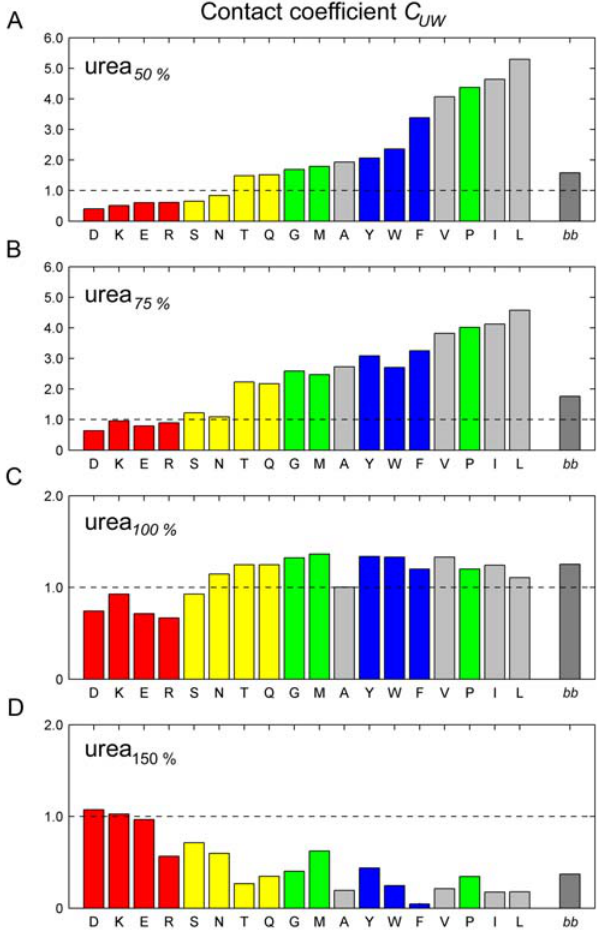
Figure 2. Interaction coefficient C UW for all amino acids types in the CI2 protein, as well as the backbone average (‘‘ bb ’’). The four panels show C UW for the different urea partial charge scalings (A: 50%, B: 75%, C: 100%, D: 150%). The color characterizes the amino acids. Red: charged, yellow: polar, gray: aliphatic, blue: aromatic, green: apolar. For better comparability, all C UW are sorted according to C UW in urea 50% .